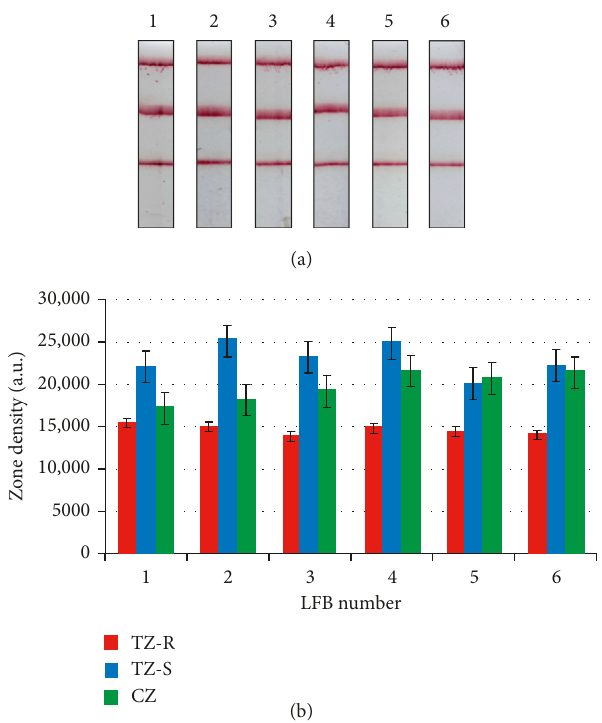
Figure 5: Reproducibility study. (a) Typical images of lateral flow biosensors with anti-biotin-gold nanoparticle conjugates after applying Dig- and Fluor-reference target mixtures as targets. (b) Optical density of the test and control zones. Graph of the intensities of the lateral flow biosensor test and control zones for reproducibility assessment (CV TZ-R : 3.9%; CV TZ-s : 8.2%; CV CZ : 9.2%, n 6). TZ-R: anti-fluorescein zone; TZ-S: anti-digoxigenin zone; (cid:31) CZ: control zone; CV: coefficient of variation.